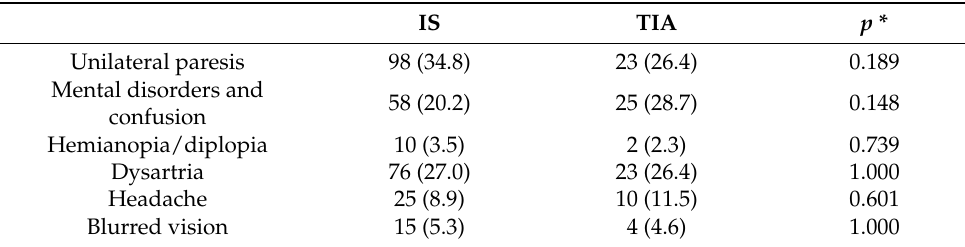
Table 1. Frequency of main neurological symptoms, present for more than 24 h in ischemic stroke (IS, n = 282) and present for less than 24 h in transient ischemic attack (TIA, n = 87).